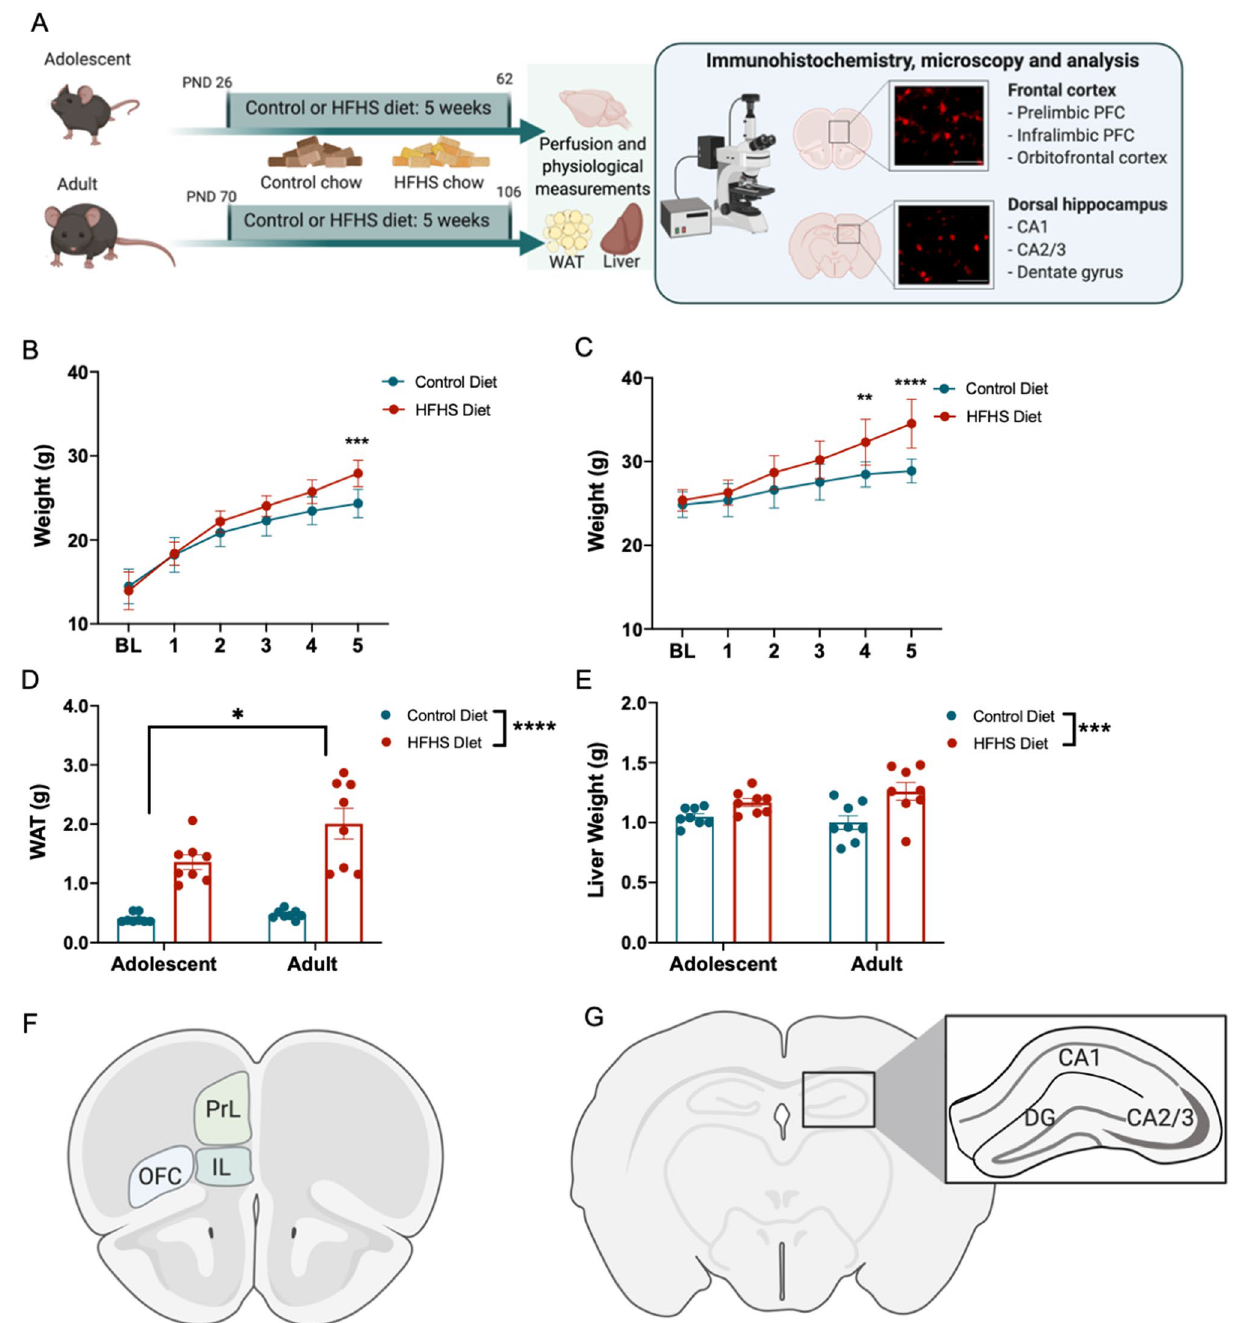
Figure 1. Physiological consequences of high-fat/high-sugar (HFHS) diet in male mice. ( A ) Timeline of the experimental procedure including diet administration and immunohistochemistry. Effect of HFHS or control diet on body weight in mice who commenced experimental diet manipulation across ( B ) adolescence and ( C ) as adults ( n = 8 male mice per experimental condition). Impact of HFHS diet on white adipose tissue mass (WAT) ( D ), and liver weight ( E ). Schematic representations of the brain regions of interest in the ( F ) prefrontal cortex (bregma + 2.1 mm) and ( G ) dorsal hippocampus (bregma -2.06 mm). Data were assessed using repeated measures ANOVA and two-way ANOVAs * p < 0.05, ** p < 0.01, *** p < 0.001, **** p < 0.0001. Panels ( A , F , G ) created with